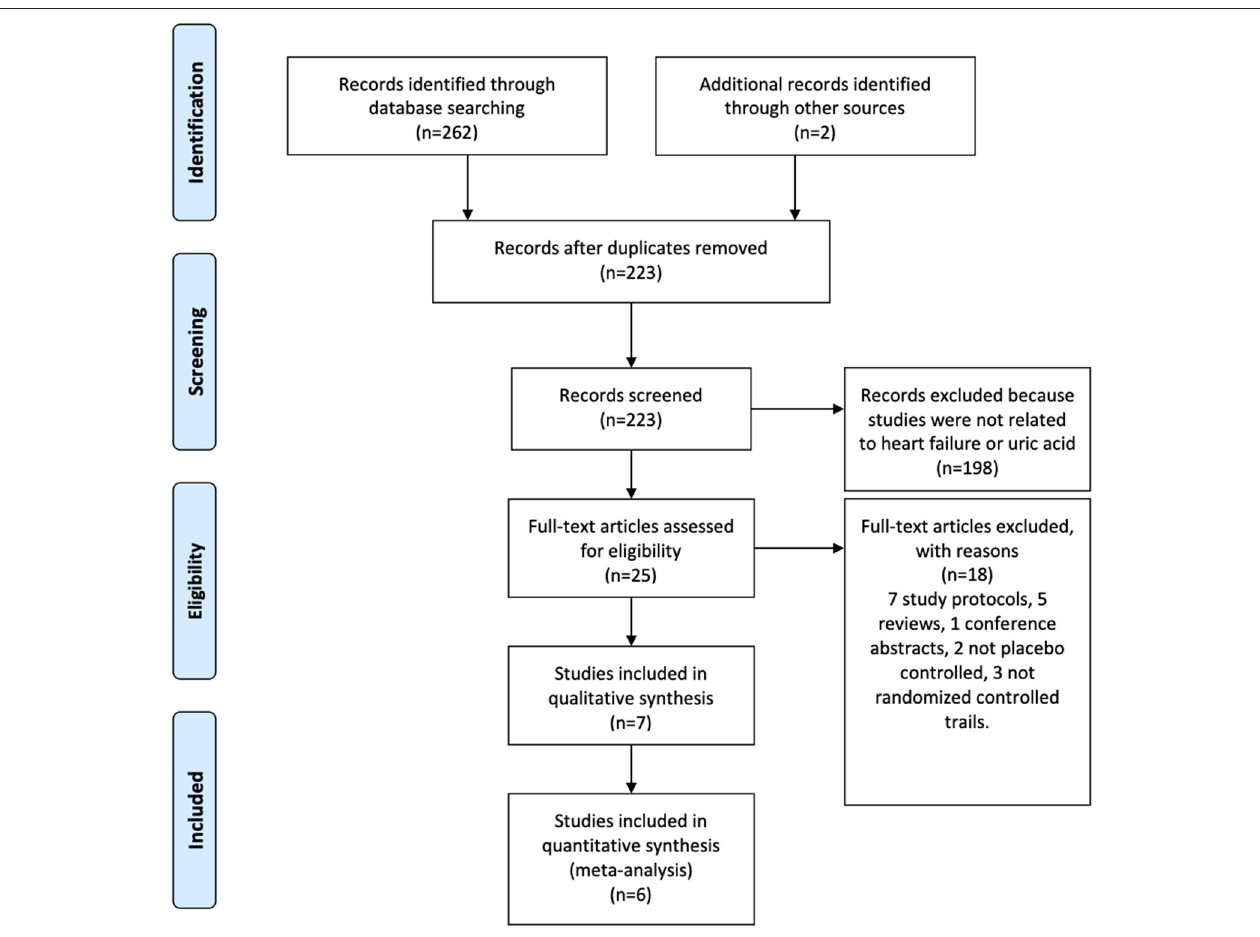
FIGURE 1 | Preferred Reporting Items for Systematic Reviews and Meta-Analyses (PRISMA) flow diagram.